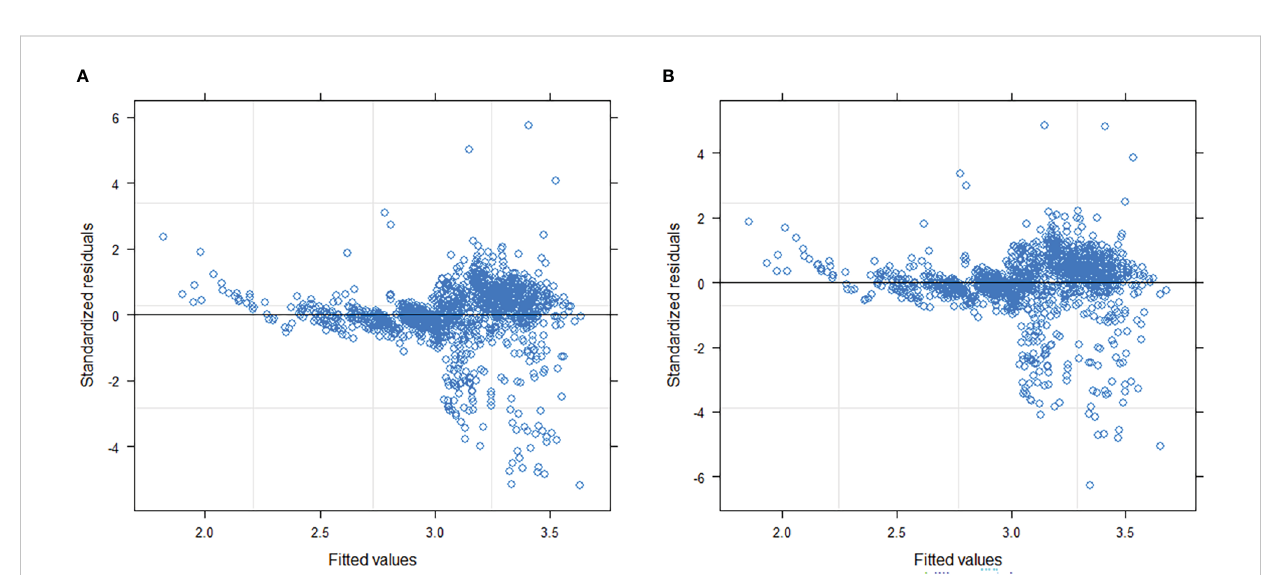
FIGURE 3 Residual distribution of Model 19 (A) and Model 19 + Eq. 15 (B) .